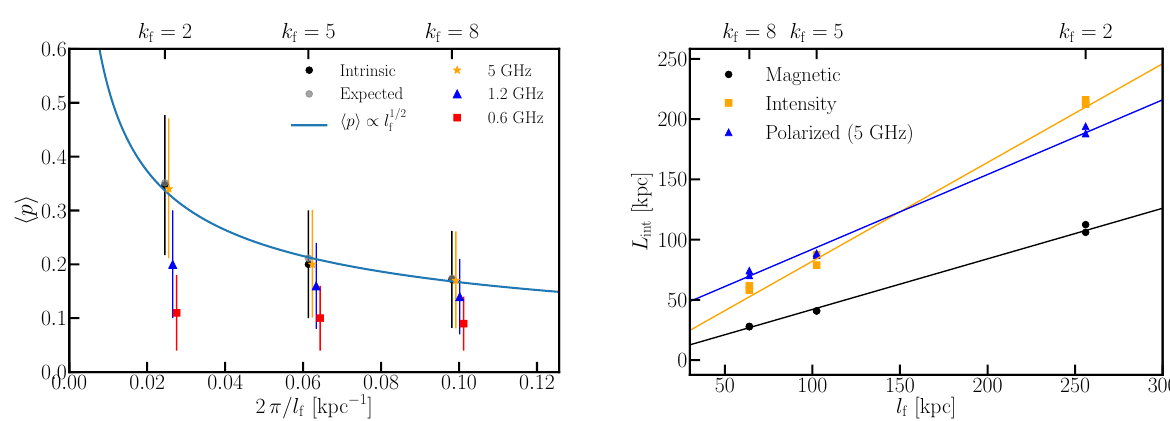
p Figure 4. ( Left ): Variation of mean fractional polarization with the turbulence driving scale l f in the saturated stage at (cid:104) (cid:105) p the native resolution of the simulations. The black points show the intrinsic from the simulated volumes computed in (cid:104) (cid:105) p the absence of Faraday rotation. The grey points show the expected computed from the magnetic integral scale. The (cid:104) (cid:105) ∝ l 1/2 p blue curve shows variation. The red squares, blue triangles and orange stars correspond to 0.6, 1.2 and 5GHz f (cid:104) (cid:105) in the presence of Faraday rotation, and they are plotted with slight offset to avoid overlap. All errors show the standard deviation of pixels in the fractional polarization maps. ( Right ): Variation of the integral scales with l f . The black, orange and blue points are for the magnetic field, total intensity and polarized intensity at 5GHz, respectively. The lines shows L int ∝ l f